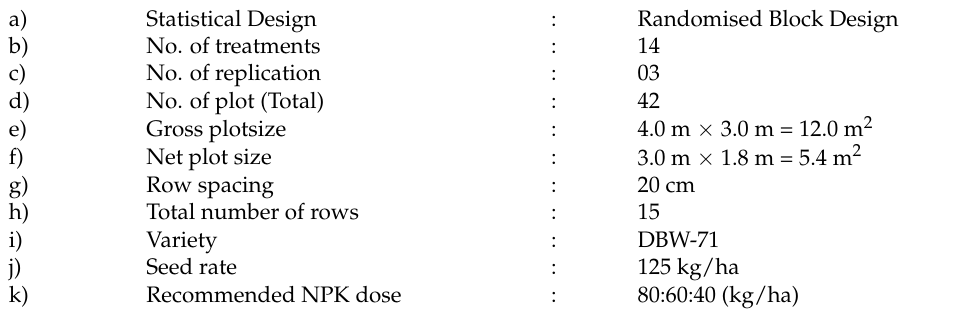
Table 1. The conditions of the